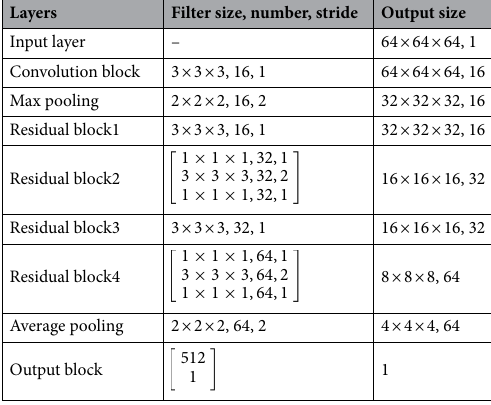
Table 3. The network architecture of D.